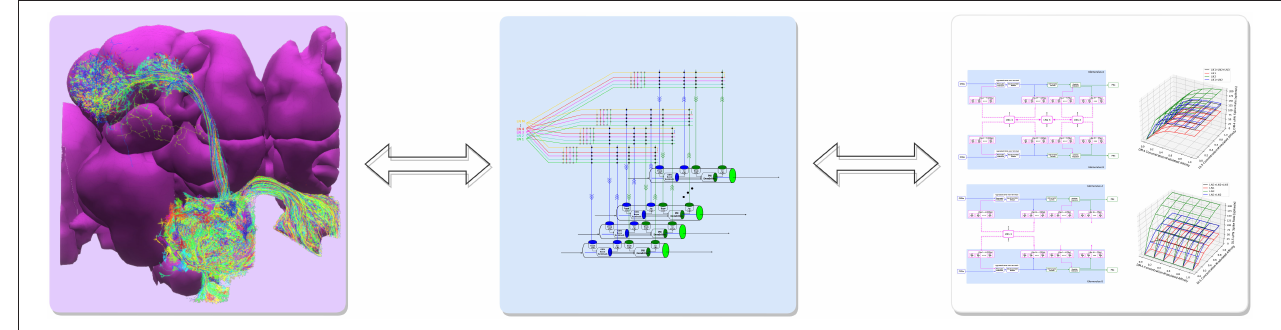
FIGURE 2 | The workflow of discovery of the functional logic of the fruit fly brain. Left: 3D visualization and exploration of fly brain data. Middle: Creation of executable circuits. Right: Interactive exploration of the functional logic of executable